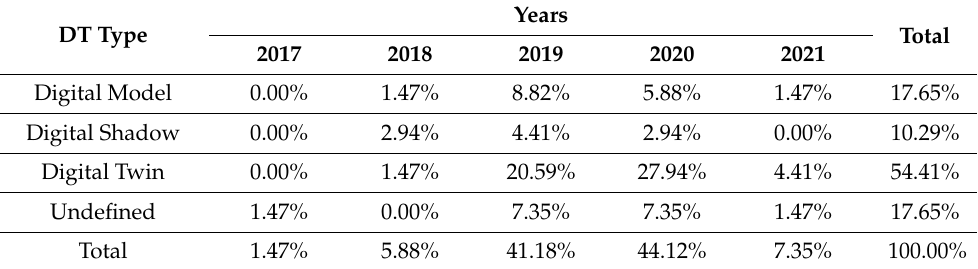
Figure 14. Type of paper for each type of DT.